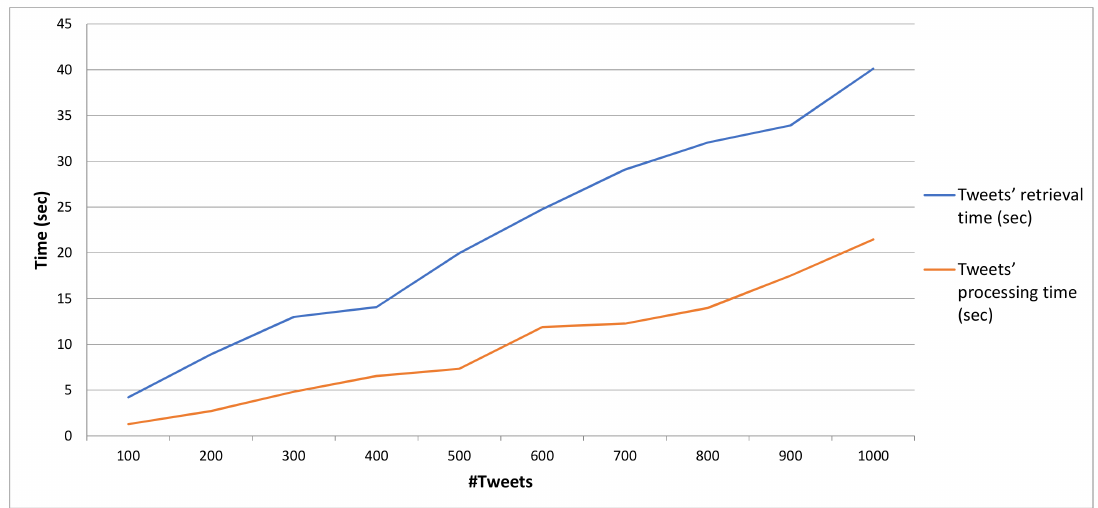
Figure 15. Time required to retrieve related Tweets using the Twitter API and overall Tweet processing time (i.e., time to clean, translate and post NGSI-modeled Tweets to a remote instance of OCB, where interoperability overhead is introduced) against the individual Tweet